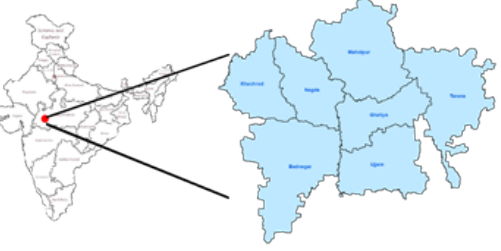
Fig.2. Study area (Ujjain district, Madhya Pradesh, India)